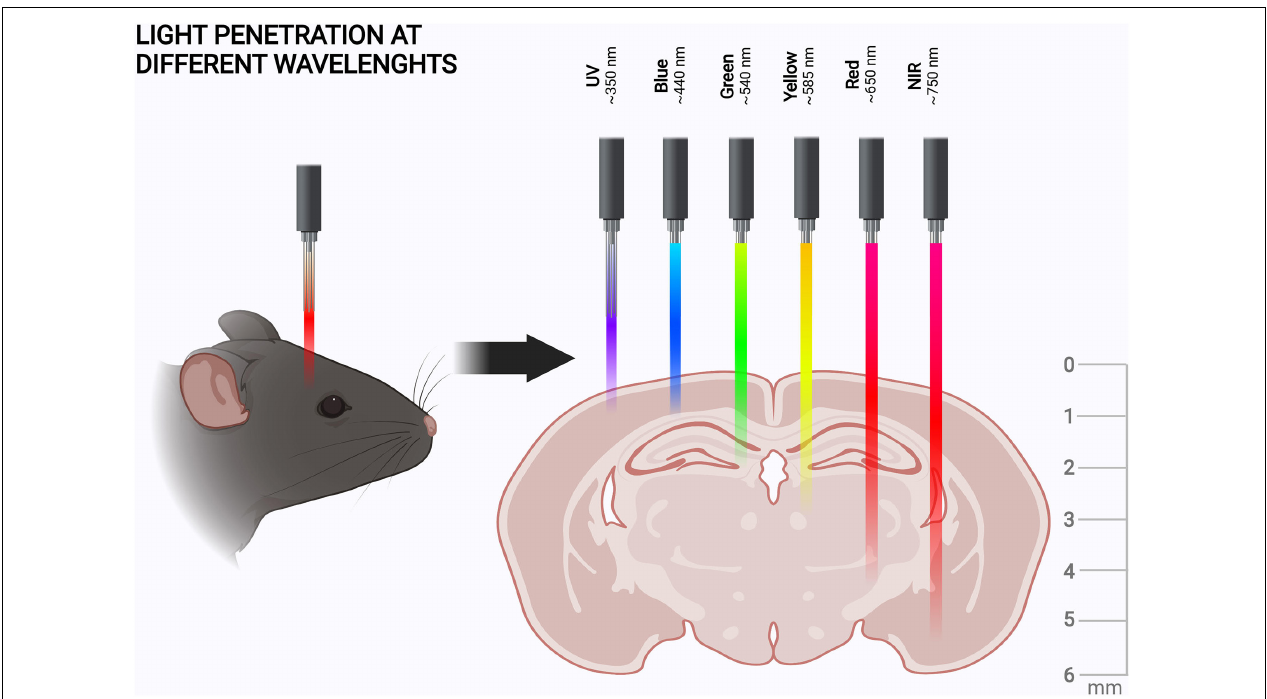
FIGURE 2 | Tissue penetration of different wavelengths of light. Tissue penetration is illustrated from the coronal view of the rodent brain. The light penetration depths, scales, and shown wavelengths are indicative (Jacques, 2013; Diem et al., 2016; Ash et al., 2017). The figure was created with